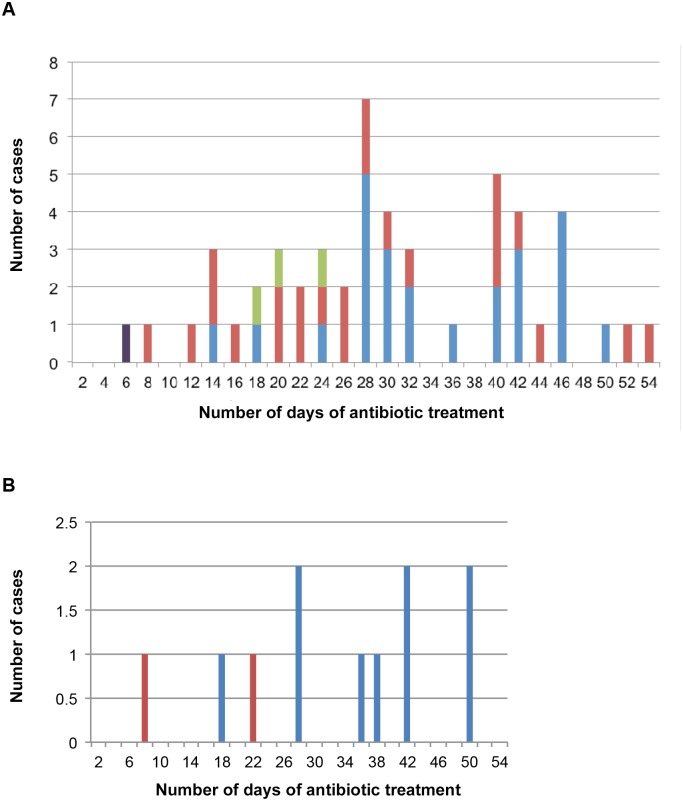
A) Purple column-Positive margin / treatment failure.Green column-Unknown margin / treatment success. Red column -Negative margin / treatment success. Blue column-Positive margin / treatment success. B) Red column-Treatment failure. Blue column-Treatment success.